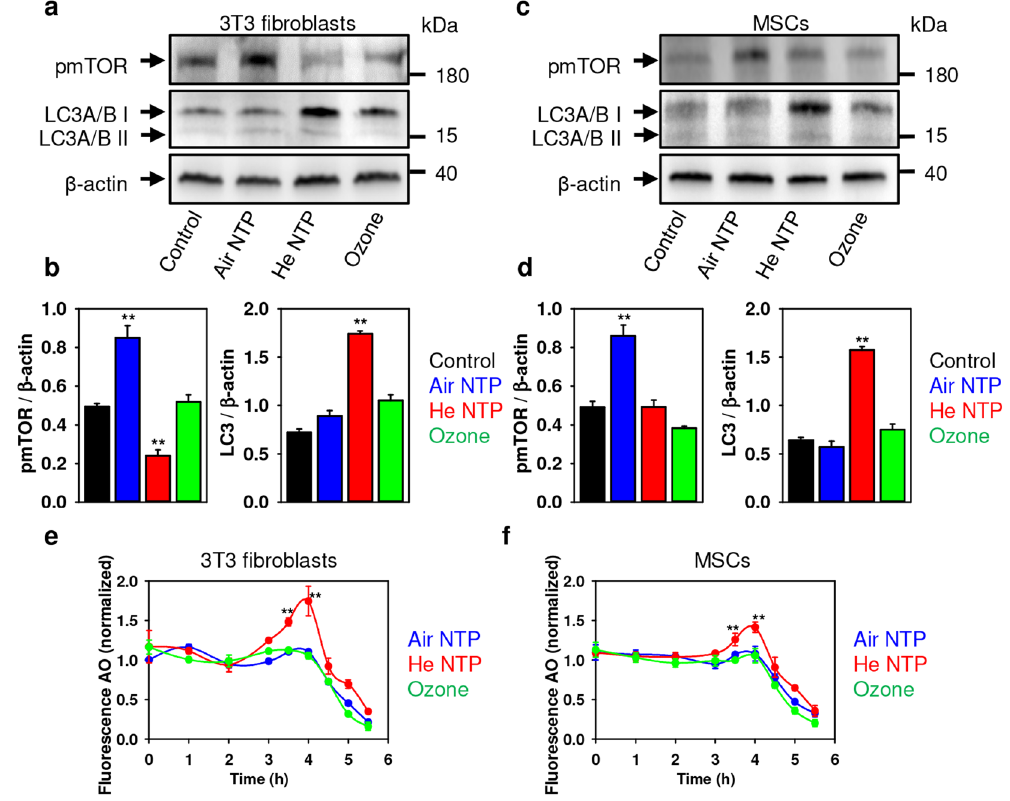
Figure 6. Effects of air, helium NTPs and ozone treatment on mTOR and LC3 activation. ( a ) 3T3 fibroblasts and ( c ) MSCs were treated with air, helium NTPs or ozone for 30 s. Cells were analyzed by Western immunoblotting 4 h after treatment. Actin – control of equal protein loading. Representative blots out of three independent experiments are shown. The graphs show densitometric quantification of the respective Western immunoblots for 3T3 fibroblasts ( b ) and MSCs ( d ), ** P < 0.01, mean ± SEM, n = 3. Air, helium NTPs and ozone effects on lysosomal integrity in 3T3 fibroblasts ( e ) and MSCs ( f ). After treatment with NTPs and ozone, cells were stained with acridine orange (AO). AO uptake in acidic lysosomes leads to red fluorescence, which dissipates when the dye leaves this compartment. The accompanying decrease in fluorescence intensity was analyzed by spectrofluorometry. The results are presented as the mean ± SEM of four independent experiments * P < 0.05 ** P < 0.01 versus